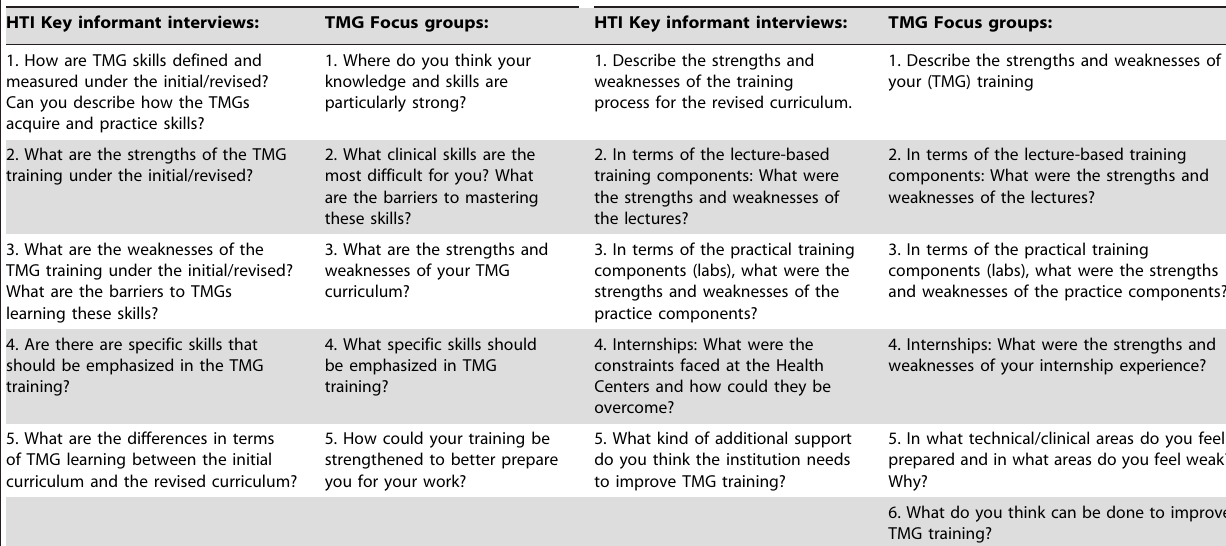
2011 and 2012 data collection (initial and revised) 2013 data collection (revised